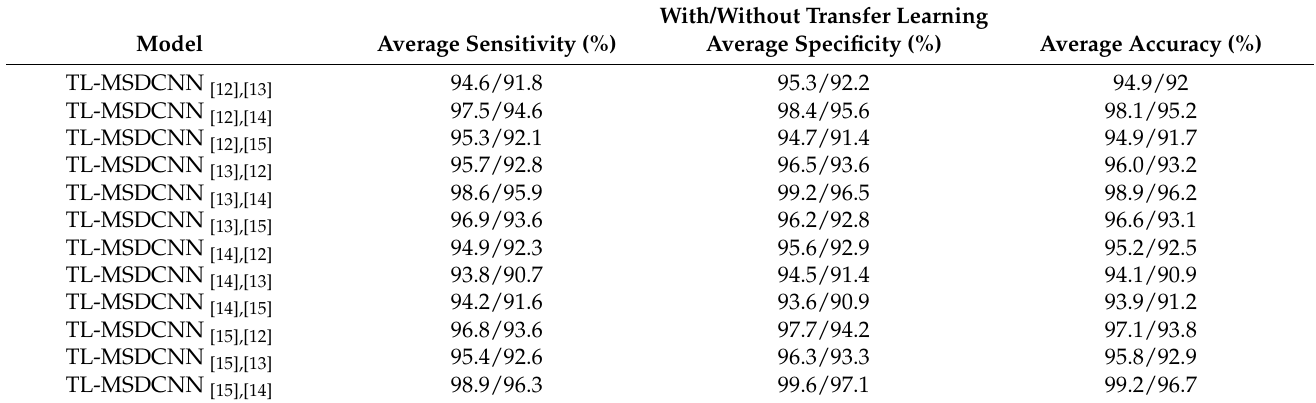
Table 8. Performance of the 12 target models using TL-MSDCNN with and without transfer learning.